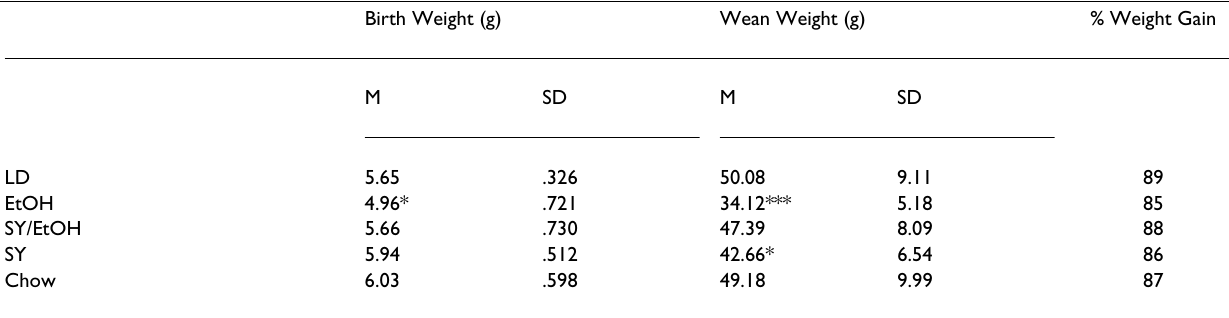
Table 1: Weight at Birth and Weaning and Percent Weight Gain Birth Weight (g) Wean Weight (g)